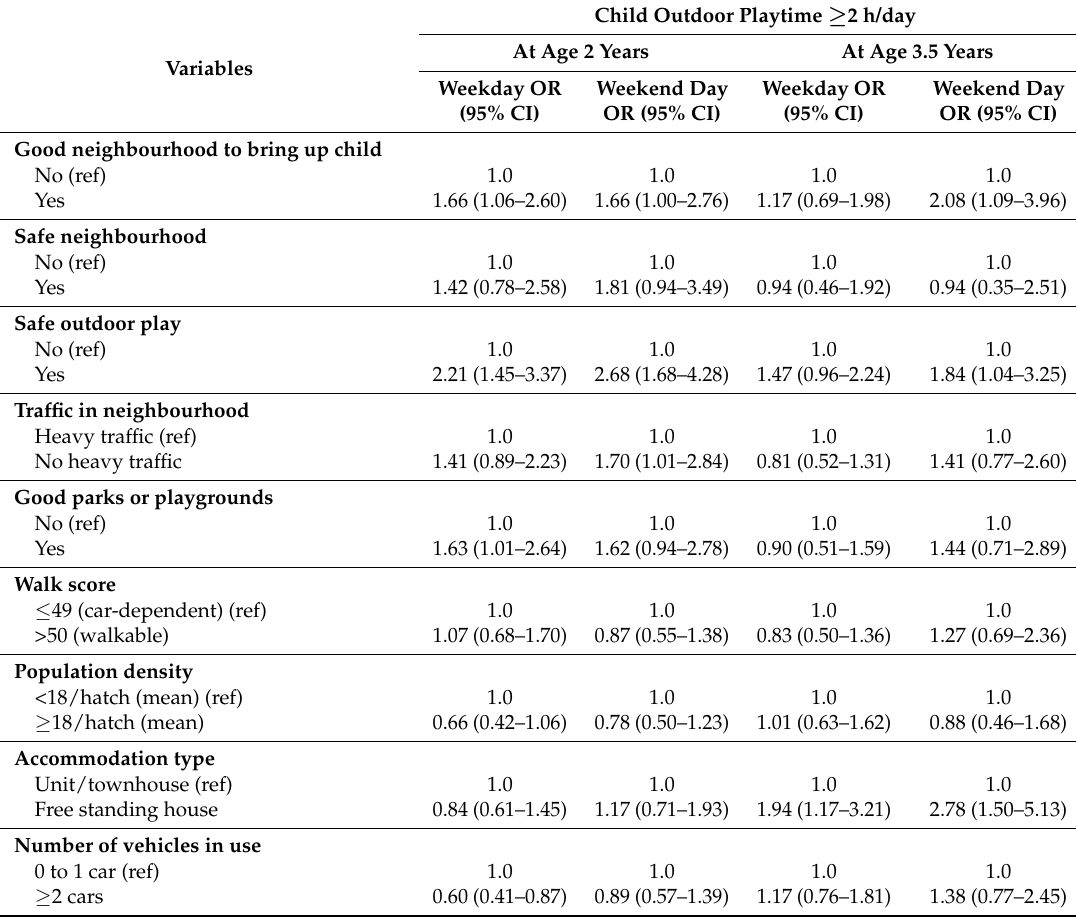
Table 3. Bivariate logistic regression analysis of the associations of neighbourhood environment factors with outdoor playtime of 2- to